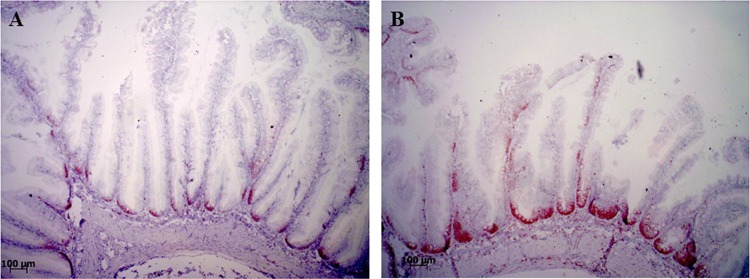
Representative images of the localization and distribution of immunohistochemically labeled PCNA protein in the epithelial cells of the distal intestine of Atlantic salmon. (A) The lowest score in the study, a score of one, with immunopositive cells mostly located in the basal areas of the mucosal folds. (B) The highest score in the study, a score of four, with immunopositive cells reaching up to 75% of the mucosal fold height.